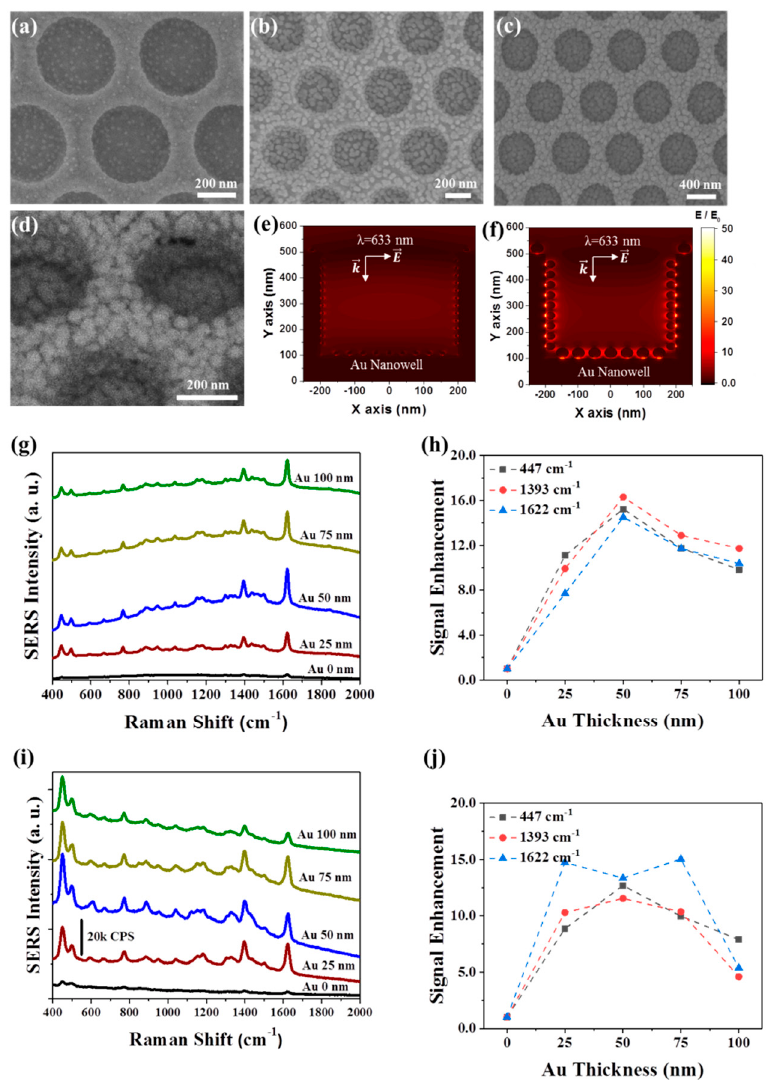
Figure 2. Optimization of Au deposition condition. ( a – d ) SEM images of the quasi-3D Au nanowell structures with four different Au deposition conditions, where the conditions for the formation of Au films with thicknesses of ( a ) 5 nm, ( b ) 25 nm, and ( c , d ) 50 nm on normal surfaces are used. ( e , f ) Spatial distributions of electric field intensity in quasi-3D Au nanowells for the conditions of ( e ) 5 nm-thick and ( f ) 50 nm-thick Au film formation. The diameters of Au NPs on the sidewall and bottom surfaces and a gap spacing are set to 10 nm, 14 nm, and 24 nm for the condition of 5 nm-thick Au film and those are set to 30 nm, 40 nm, and 9 nm for the condition of 50 nm-thick Au film, based on SEM observation. Raman spectra of methylene blue (MB) taken using the quasi-3D Au nanowells with 5 different deposition conditions of Au deposition using ( g ) 633 nm and ( i ) 785 nm lasers. Variation of surface-enhanced Raman spectroscopy (SERS) intensity at Raman shifts of 447 cm − 1 , 1393 cm − 1 , and 1622 cm − 1 according to the Au deposition condition for ( h ) 633 nm and ( j ) 785 nm lasers.